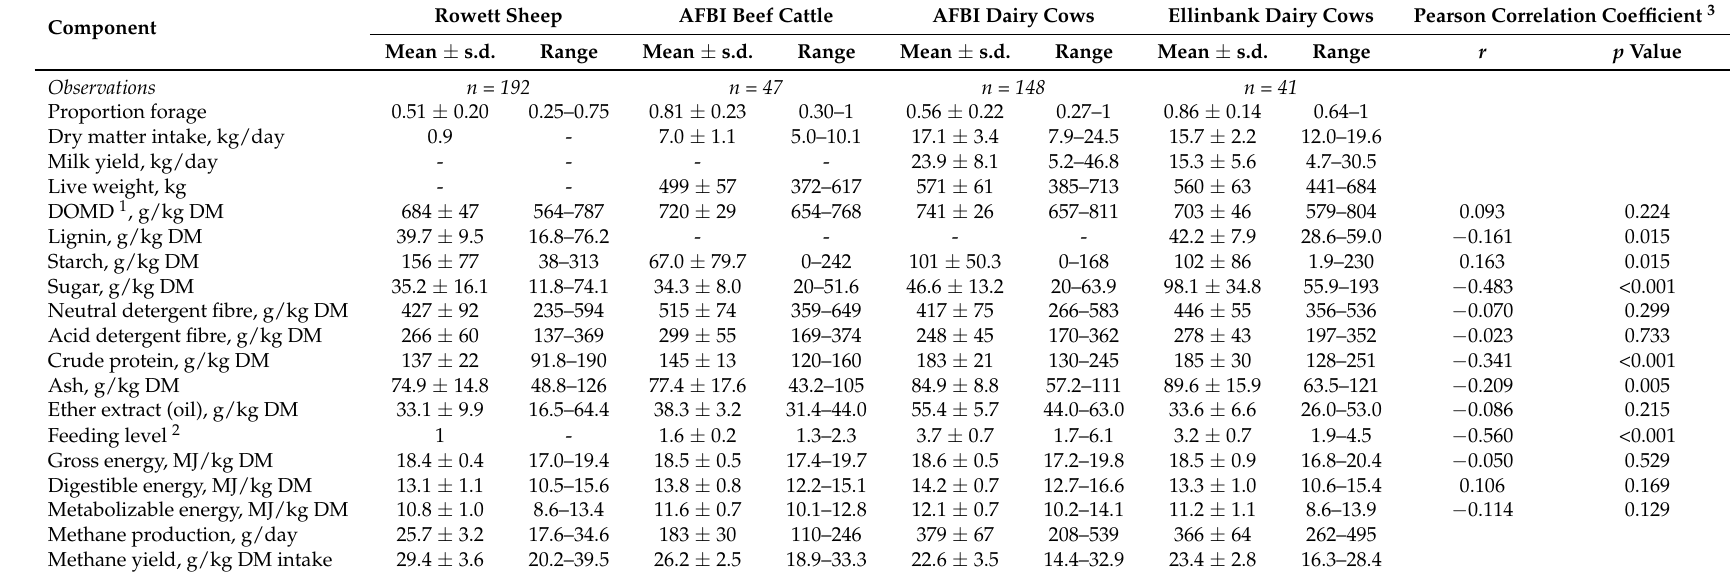
Table 1. Average production values and composition of diets fed to sheep at the Rowett Institute [13], beef cattle and dairy cows at AFBI and dairy cows at Ellinbank Research Centre for data used to develop CH 4 prediction